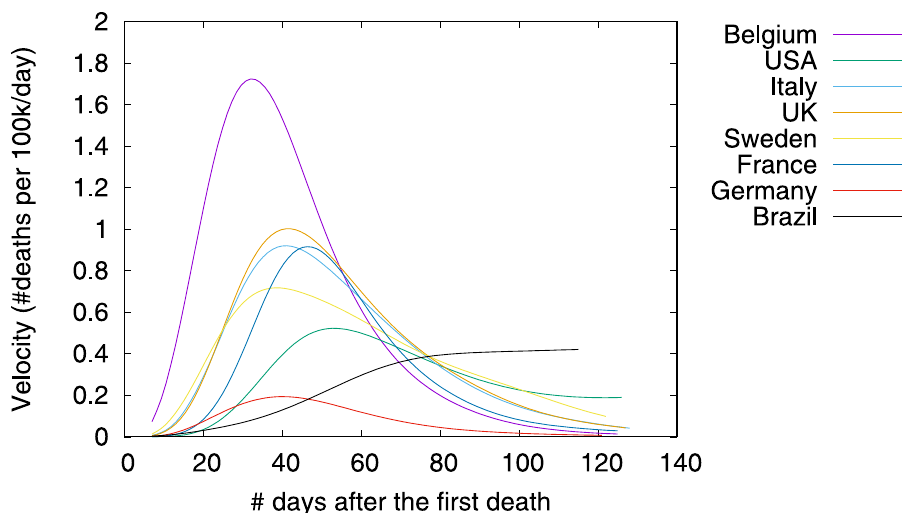
Fig 2. COVID-19 velocity (first-order derivative), as of June 5th 2020.